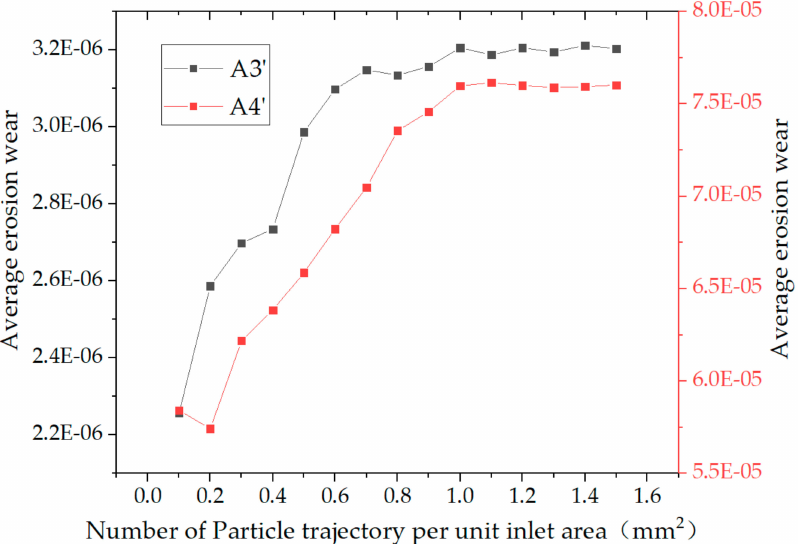
Figure 9. Independence test of the particle trajectory